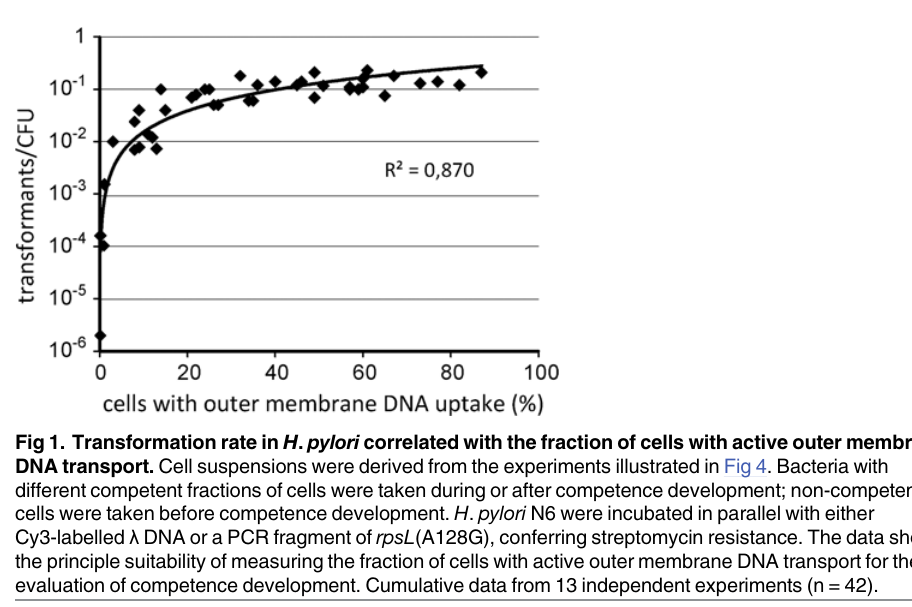
lower limit of counted bacteria with active DNA transport was 0.2% (n (cid:1) 500 cells). When